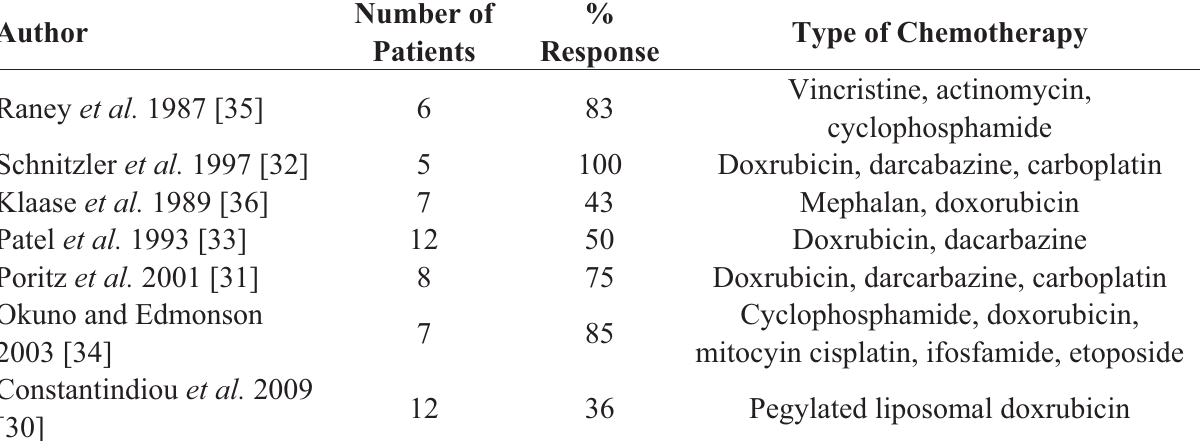
Table 3. Cytotoxic chemotherapy response rates of prior studies evaluating the effects of chemotherapy on